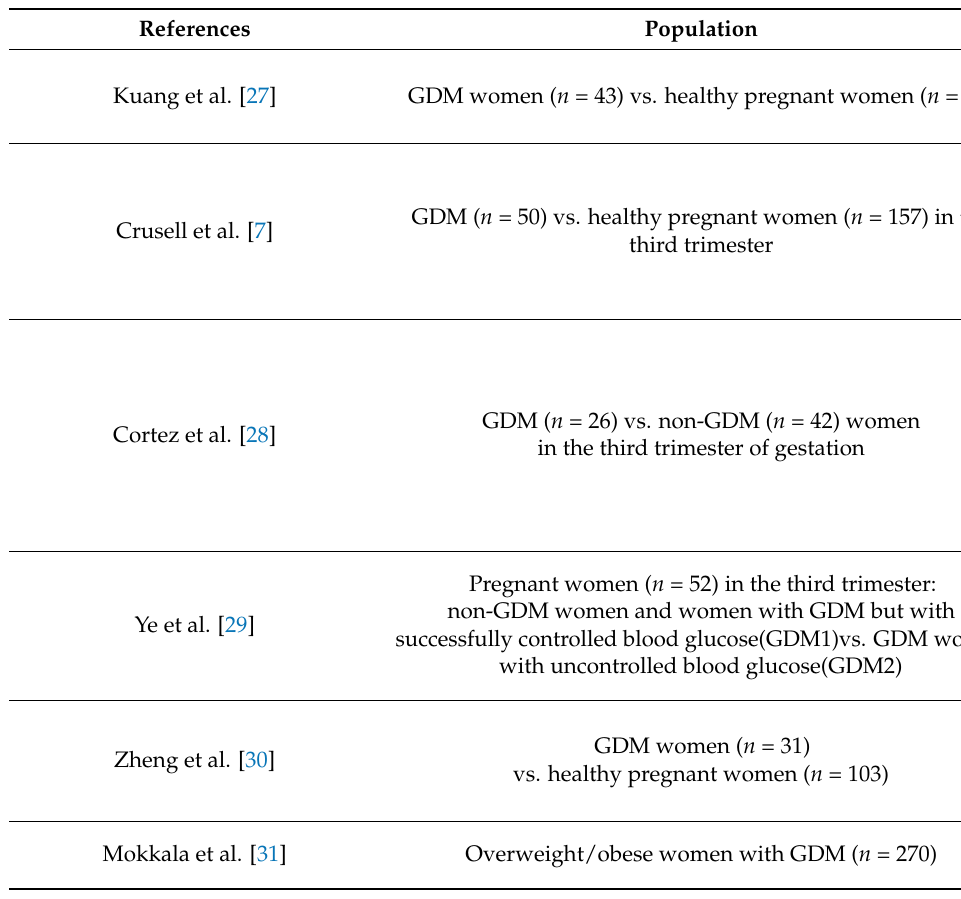
Table 1. The differences in the GMs of gestational diabetes mellitus (GDM) and normoglycemic pregnant